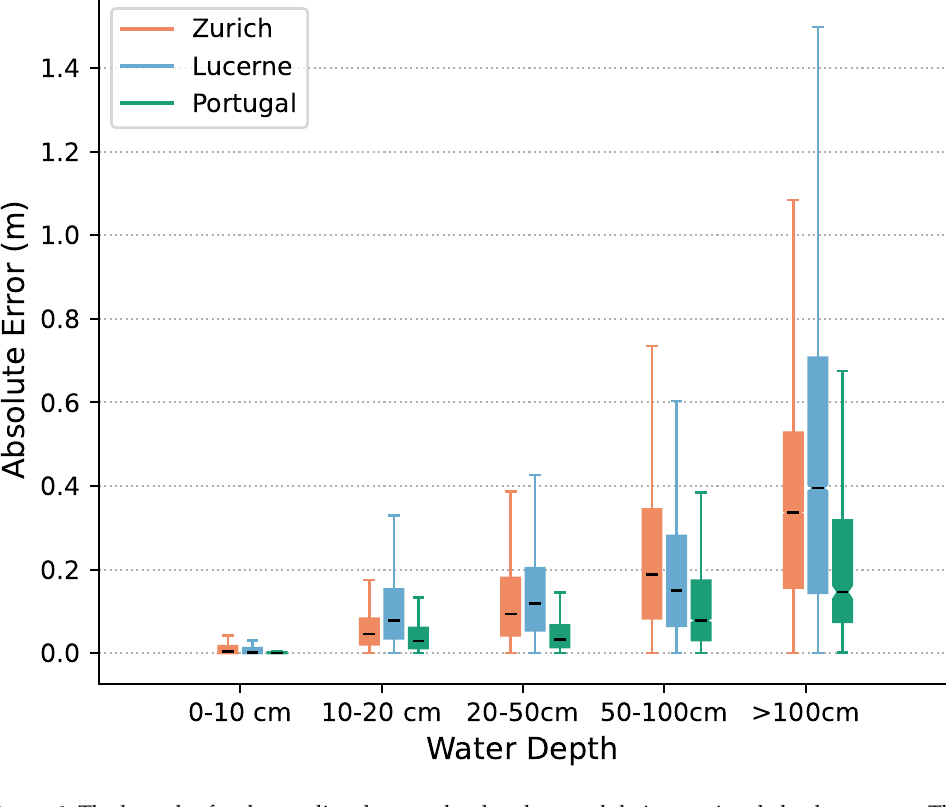
Figure 6. The box plot for the predicted water depth values and their associated absolute errors. The predictions are reported for our Deep Flood tested on steep test catchment and rainfall event tr2_1